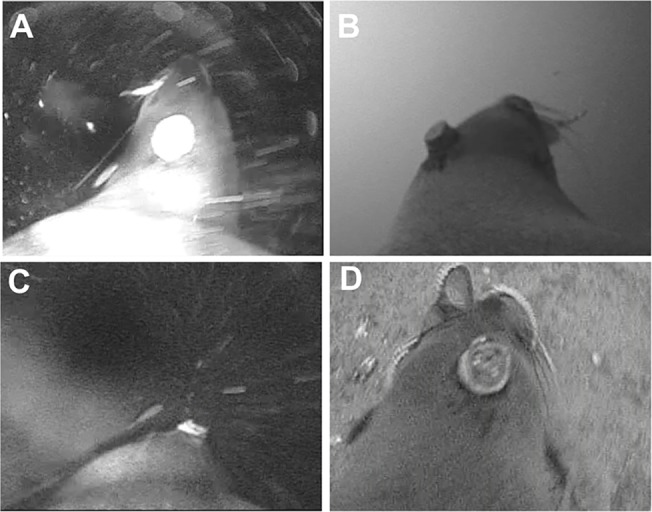
Still captures from the Crittercam video on Australian fur seals.Examples of prey and potential outcomes included a successful fish capture (A), successful stingray capture (B), unsuccessful fish capture (fish left of seal’s head, C), and successful octopus capture. A 3-dimensional accelerometer mounted on the fur seal’s head was used to measure acceleration during foraging.